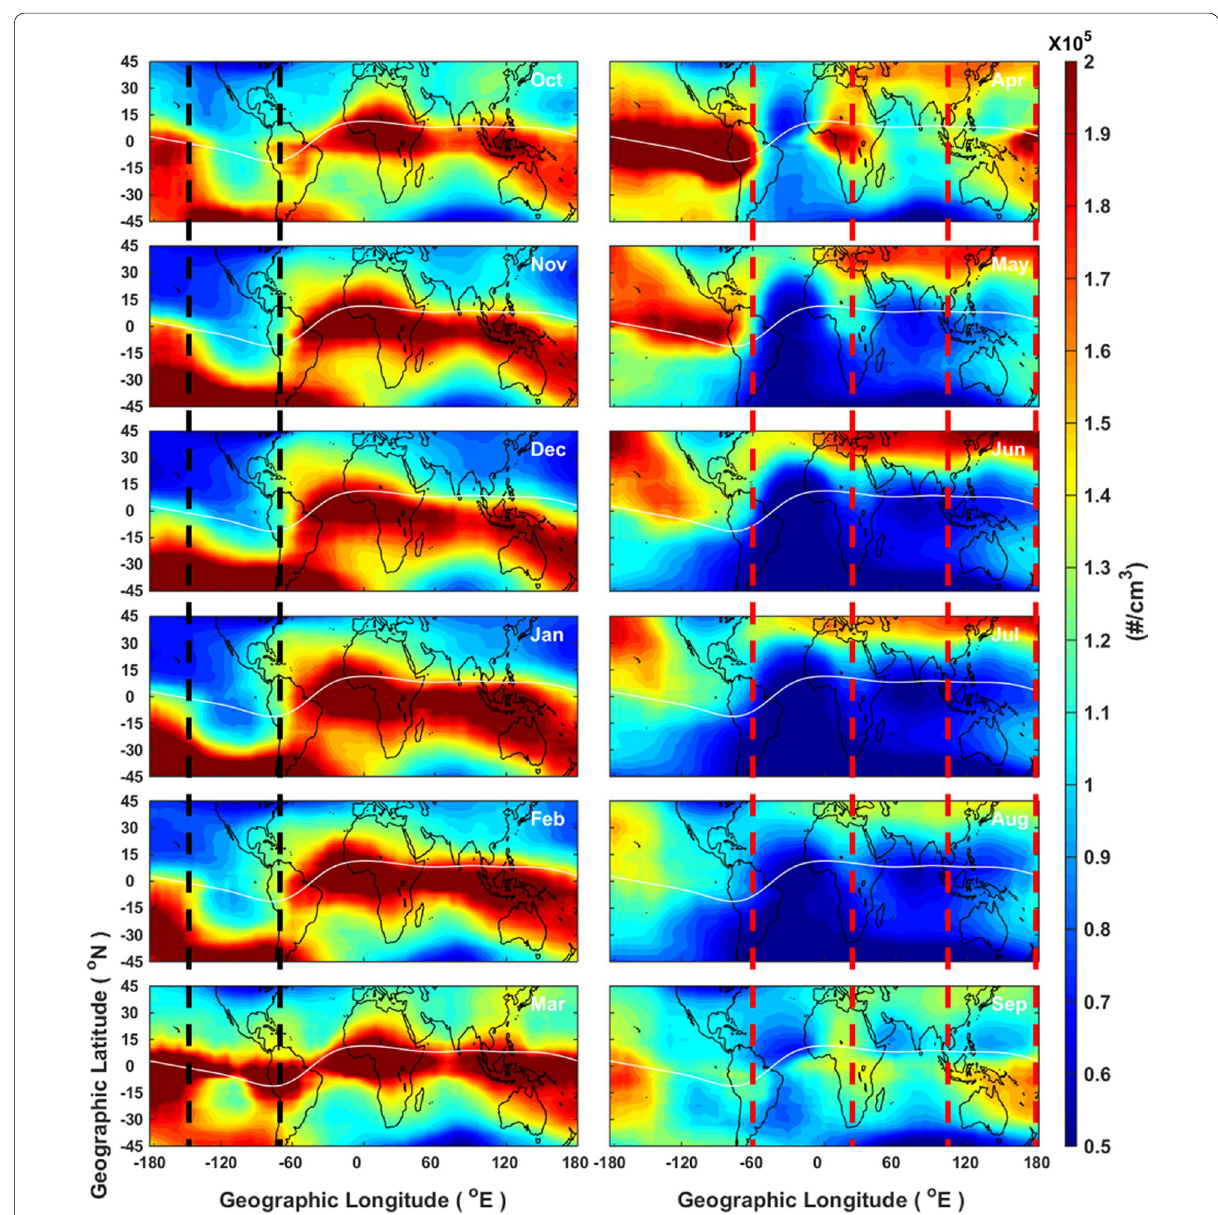
Fig. 3 Monthly plots of the F‑3/C electron density at 300 km in the global constant local time maps at 2300 LT of 2008. Black and red dash lines indicate the longitudinal sectors of the one North PDB and the three South PDBs, respectively. The F3/C occultation observations are first subdivided into 12 months by binning about 60 days of data (i.e., from 15 days prior till 15 days after for each month) in every two‑hour interval and median value of the soundings within each 5° 2.5° (longitude‑latitude) grid at 25 km altitude levels is ×